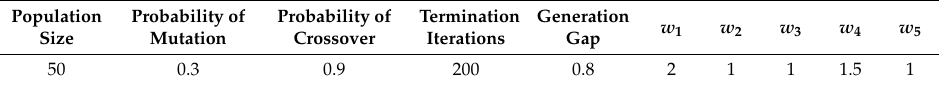
Figure 3. Identification process of GA. Table 1. Genetic algorithm tuning parameters.